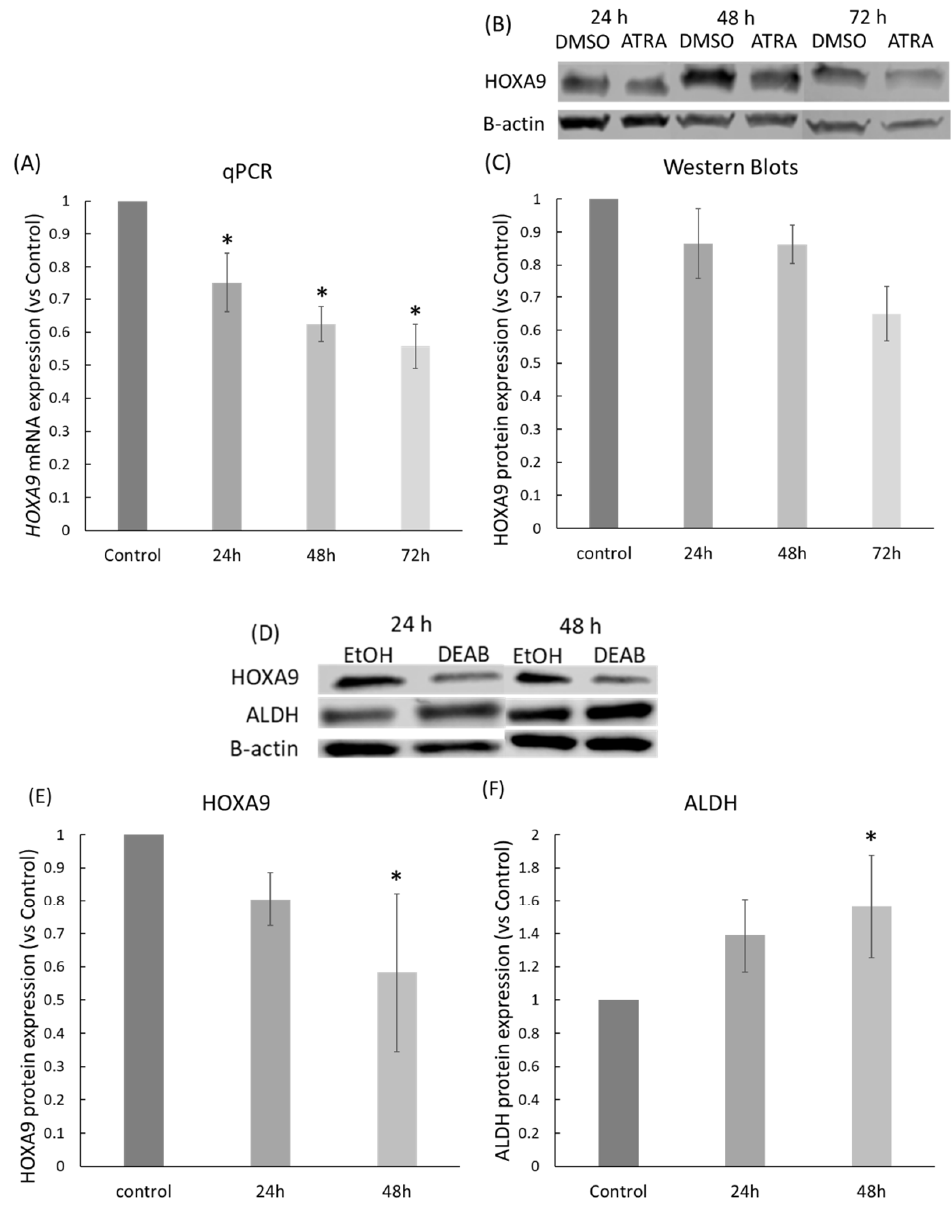
Figure 3. ATRA and DEAB treatments of HT29 CRC cells decrease HOXA9 expression. ( A ) RT-qPCR of HT29 cells treated with ATRA at IC50 concentration for 24, 48, and 72 h. Expression of HOXA9 according to RT-qPCR results was normalized to that of B-tubulin; ( B ) western blot of HT29 cells treated with ATRA at IC50 concentration for 24, 48, and 72 h. Densitometry of western blot ( C ) represents adjusted mean ratio of reduced HOXA9 expression in ATRA-treated cells; ( D ) western blot of ATRA- and DEAB-treated HT29 cells at IC50 concentrations for 24 and 48 h. Densitometry of the blots ( E , F ) represents the adjusted mean ratio of changes in HOXA9 and ALDH expression in ATRA- and DEAB-treated cells. All western blots were normalized to β -actin and vehicle control expression. Asterisks indicate significance compared to vehicle control ( p ≤